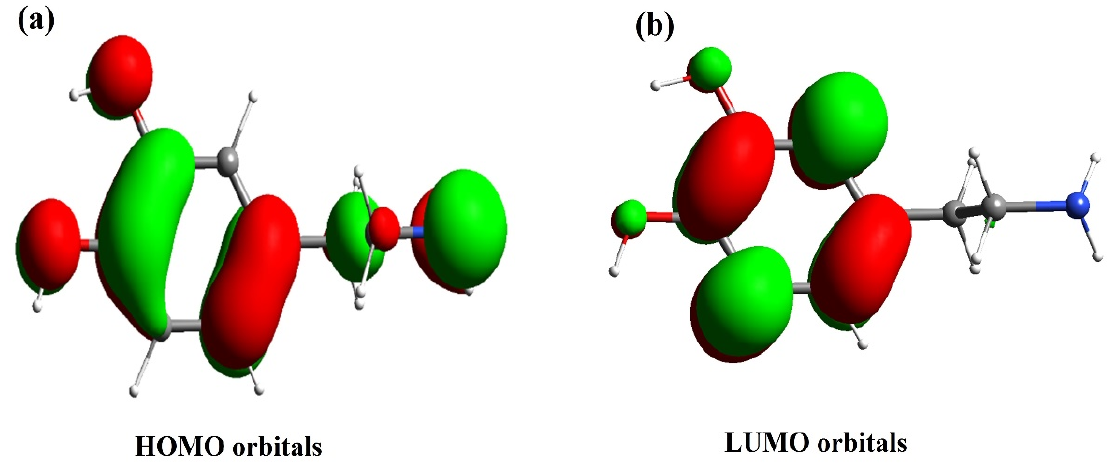
Figure 9. Frontier molecular orbitals.